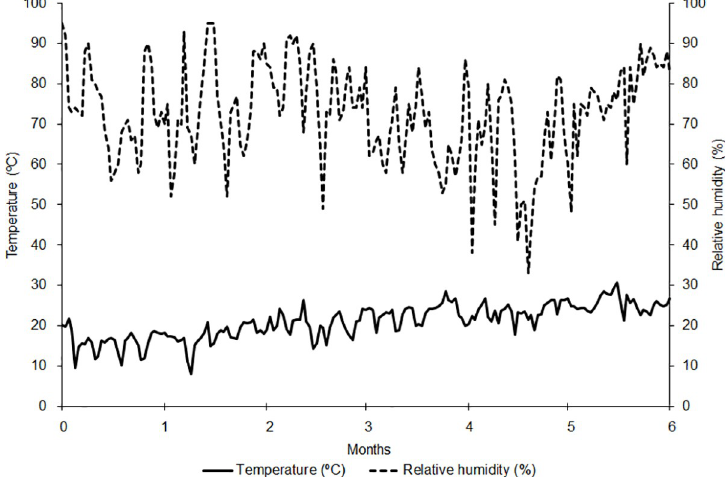
Fig 2. Average temperatures (˚C) and relative humidity (%) obtained over the storage time of soybean